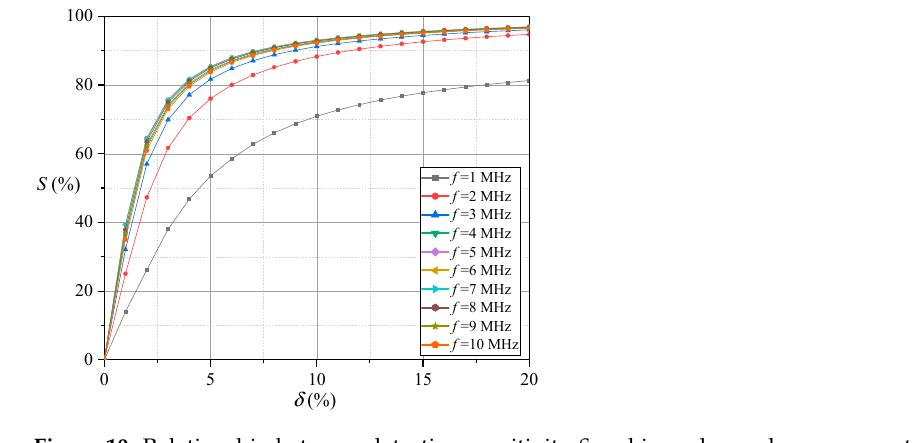
Figure 10. Relationship between detection sensitivity S and impedance change percentage δ with different frequencies.